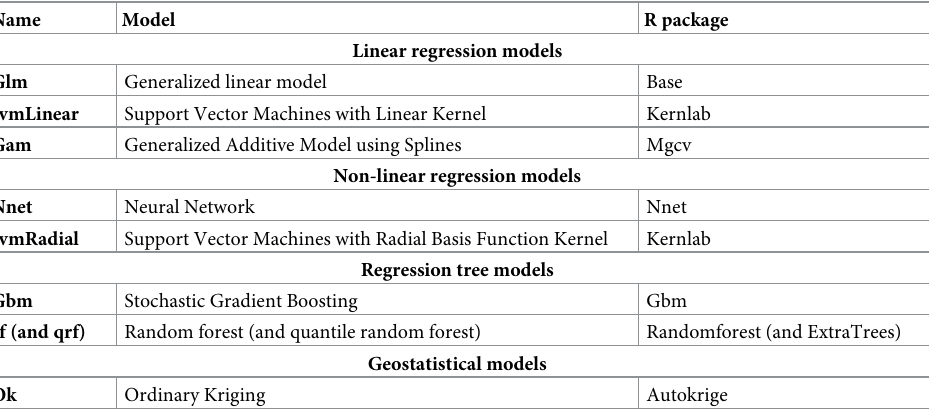
Table 3. Statistical algorithms tested in this